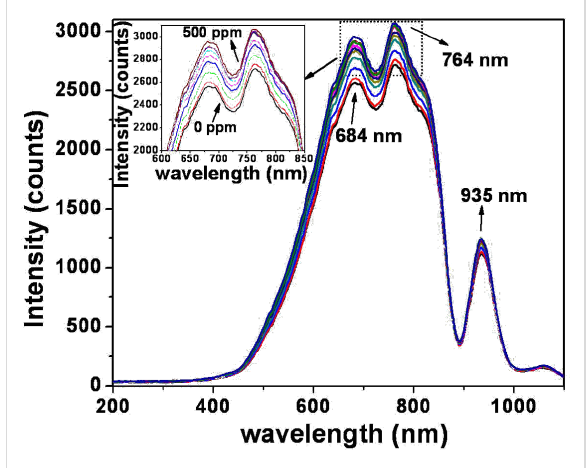
Figure 10: Spectral response of h-MoO 3 for varying concentration of ethanol in ppm.